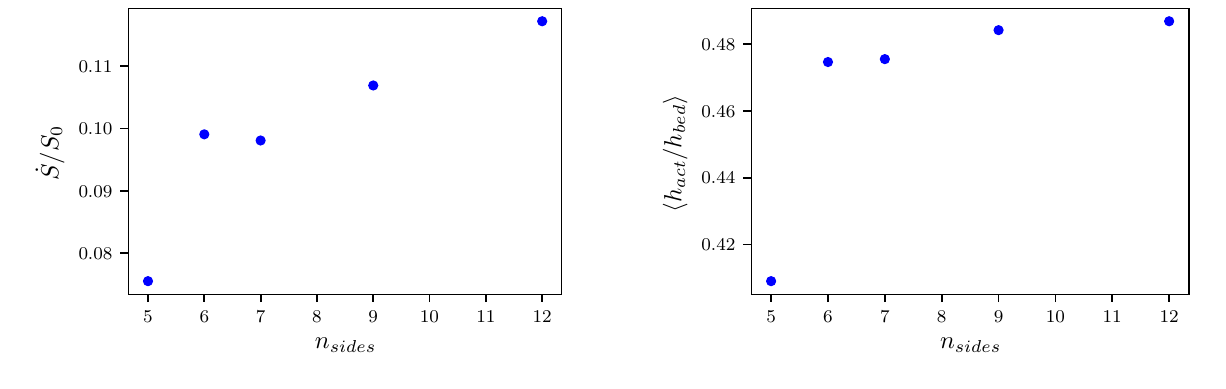
Figure 3. Grinding rate ˙ S / S 0 for samples of polygons with dif- ferent numbers of sides n sides .